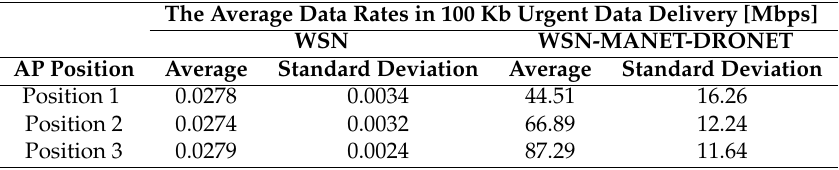
Table 5. The average data rates in 100 Kb urgent data delivery from source WSN sensor to